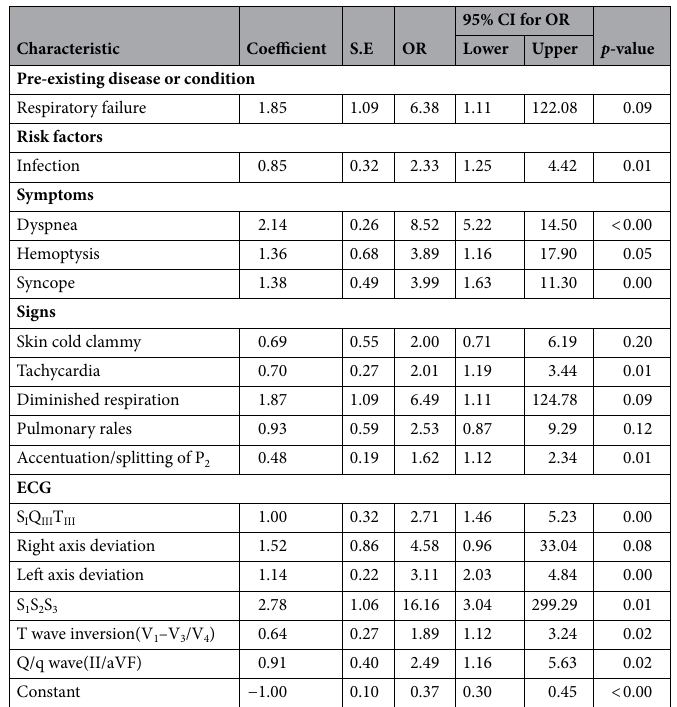
Table 2. The APE risk prediction model based on independent predictors of acute pulmonary embolism in training set. CI confidence